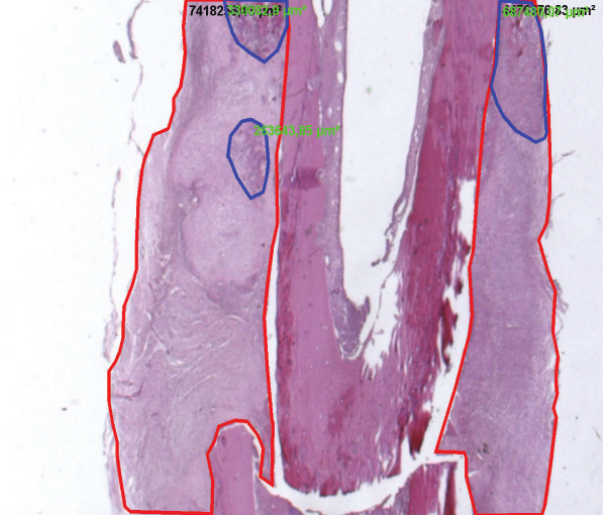
Figure 6 - Bone neoformation (blue) Figure 5 - Bone callus